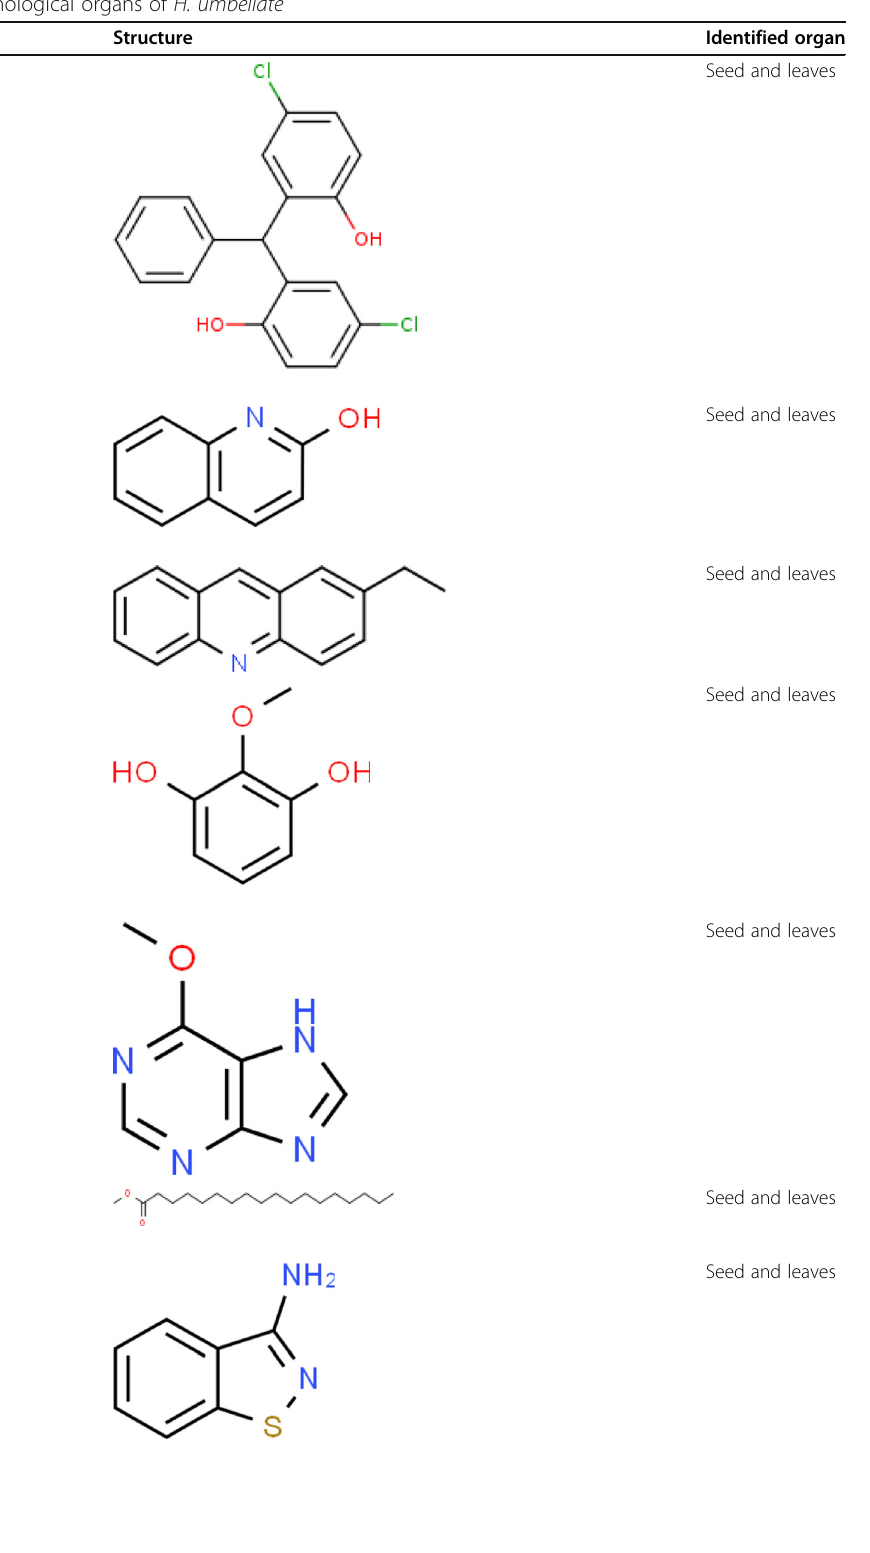
Table 4 Other compounds from morphological organs of H.